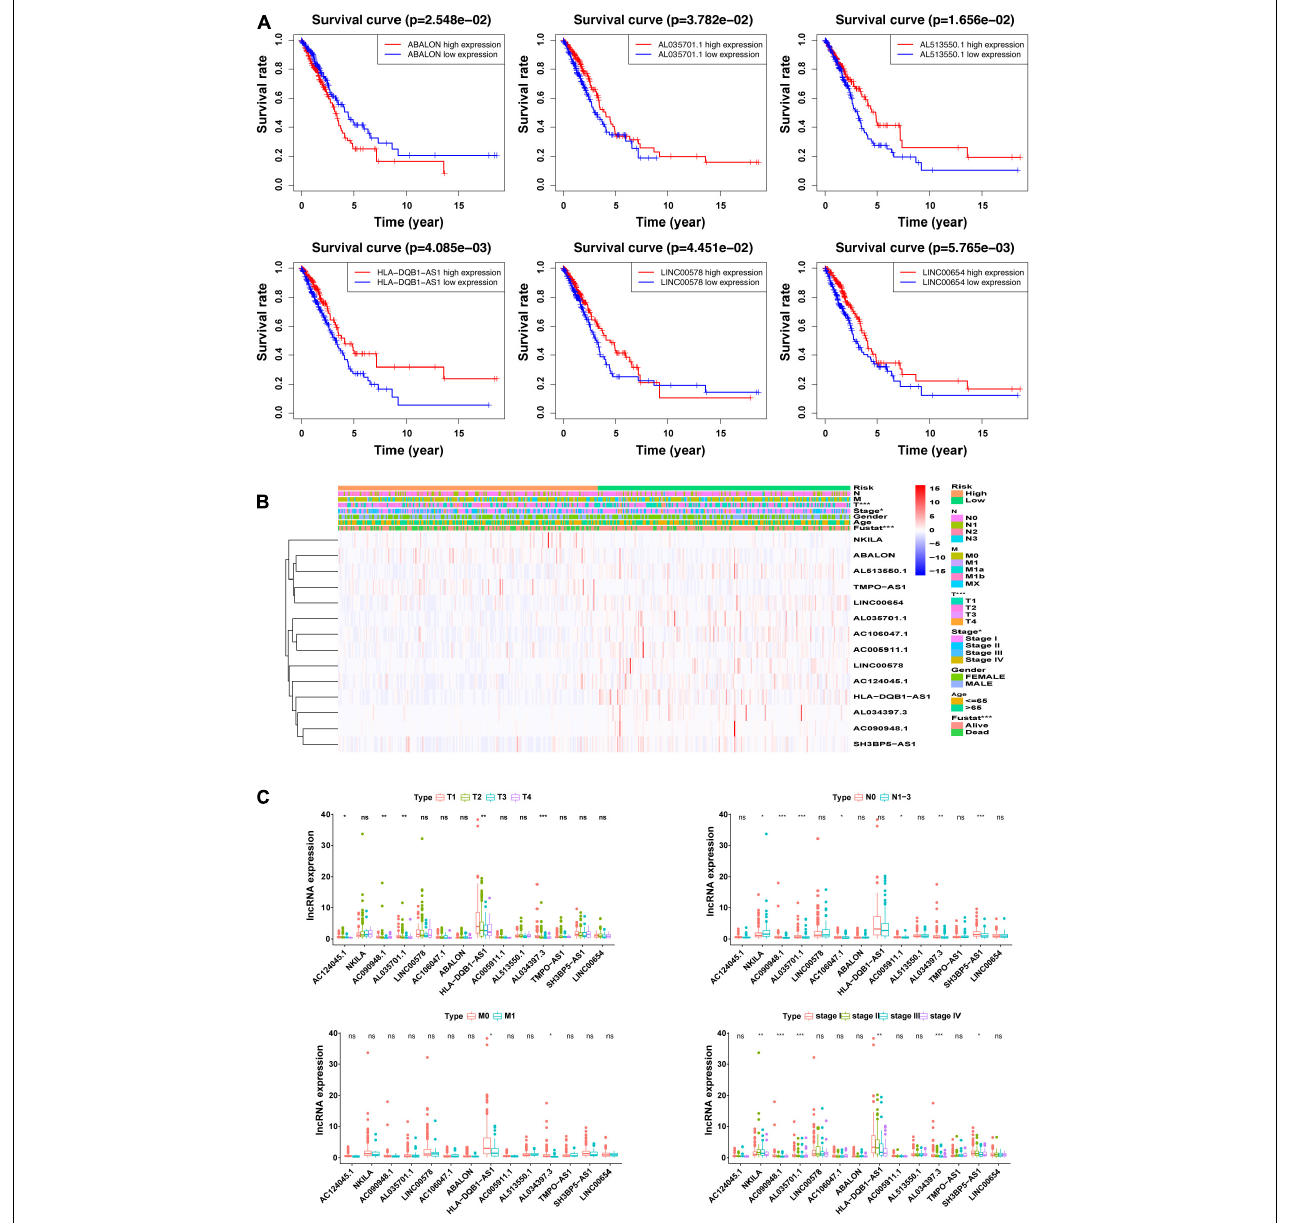
FIGURE 4 | Correlation between the expression of the 14 m5C-related lncRNAs and clinicopathological factors. (A) overall survival (OS) analysis of the 14 m5C-related lncRNAs in the GEPIA database between high- and low-expression groups. (B) Heatmap showing clinicopathological features and differences in gene expression in the high- and low-risk group. (C) Differences in the expression of the 14 m5C-related lncRNAs in T, N, M, and S stage groups. * p < 0.5, ** p < 0.01, and *** p < 0.001. ns, no